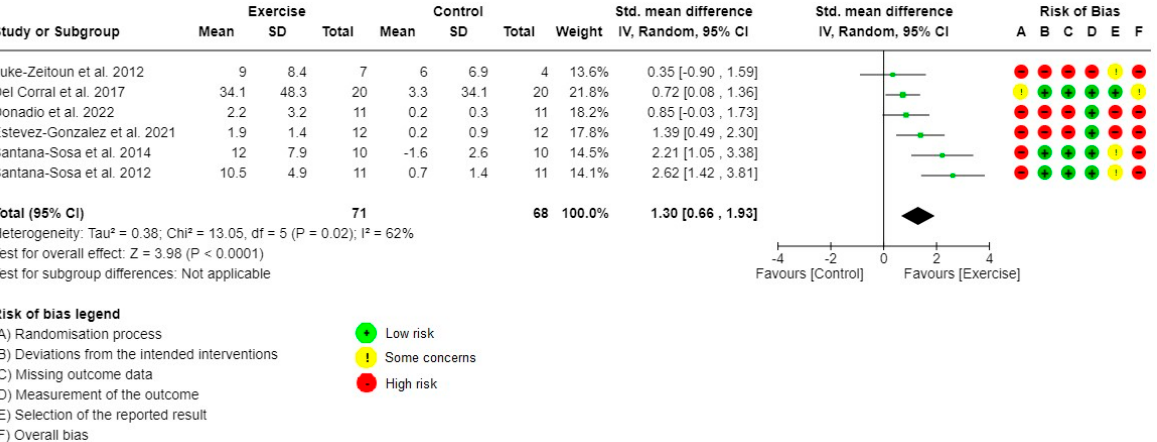
Figure 3. Forest plot for comparisons and risk of bias: Exercise versus Control, Outcome 1: Upper limb muscle